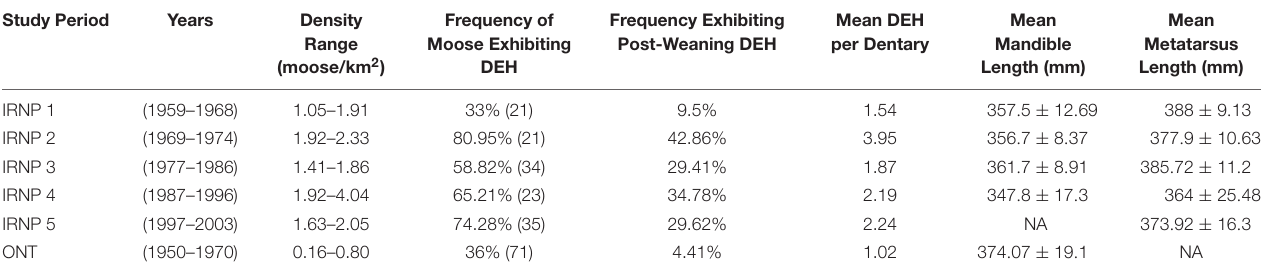
TABLE 1 | Time periods of study, population density, frequency of dental enamel hypoplasias (DEH), average score of hypoplasias and mean bone length measures for two moose localities. Study